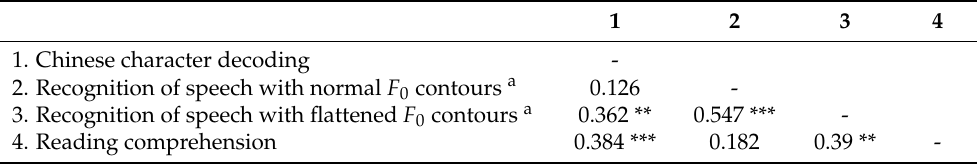
Table 2. Correlations between variables after controlling for age and sex.